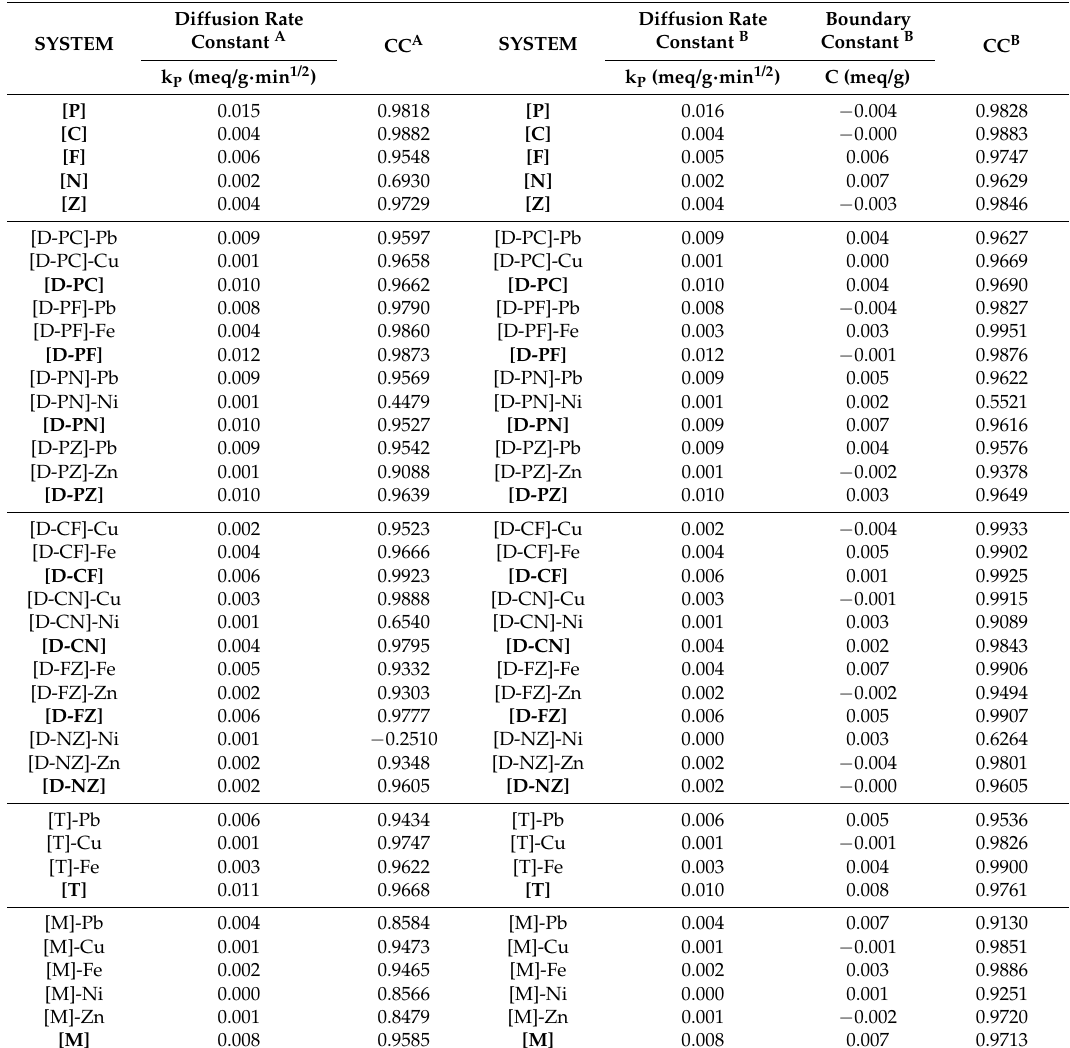
Table 5. Intra-particle diffusion